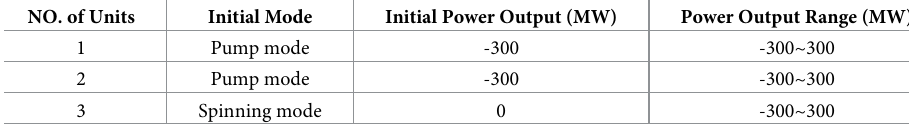
Table 6. Initial parameters of pumped storage units.